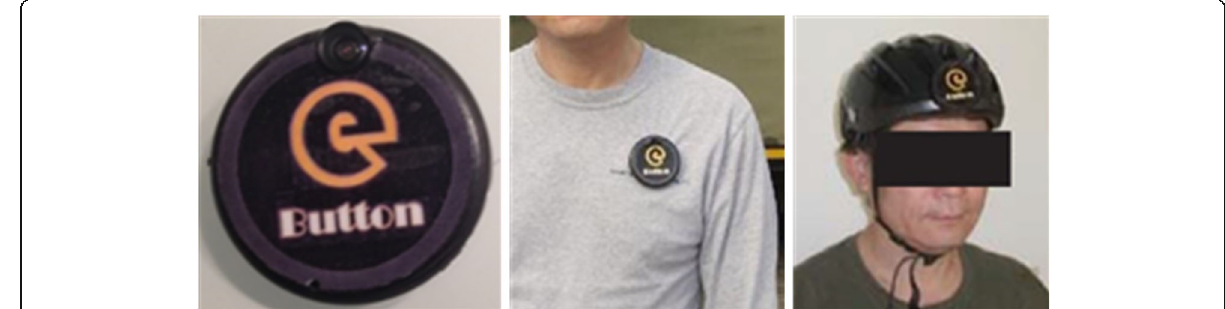
Fig. 5 Appearance of the eButton and examples of its wearing